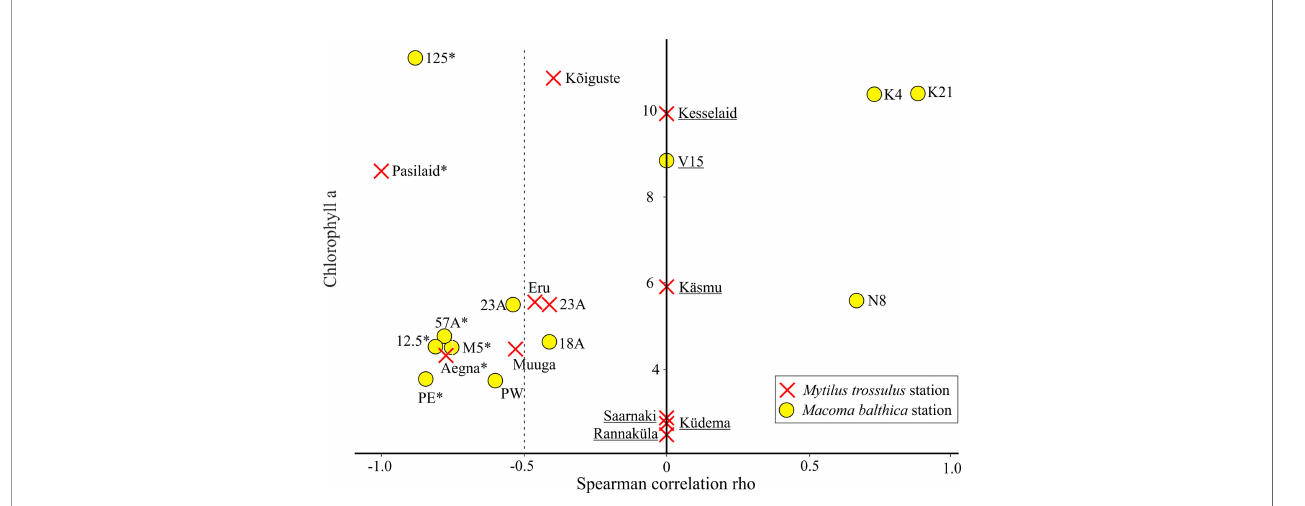
FIGURE 5 | Relationship between chlorophyll a concentration (average of 2000-2019) and the strength of correlations between prey model residuals and the biomass of goby (Rho value). Due to small sample size Rho values could not be calculated for some stations (underlined) and these stations were assigned Rho = 0. Dashed vertical line indicates spearman rho value signi fi cance threshold and stations on the left are under strong negative pressure from round goby. Stations with statistically signi fi cant correlation (p < 0.05) is marked with